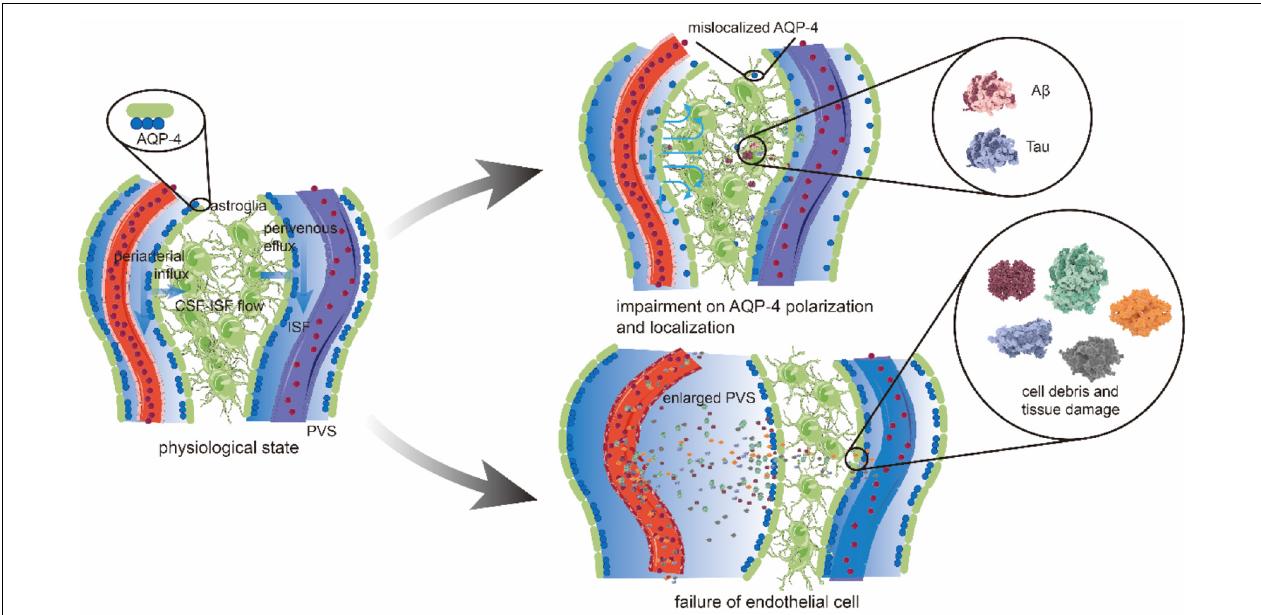
FIGURE 2 | The glymphatic pathway and pathological changes. CSF in periarterial spaces flows across the glial basement membrane and astroglial endfeet to enter the brain parenchyma. The aquaporin 4 (AQP4) is highly expressed on the endfeet of astrocytes, forming the outer wall of the perivascular space (PVS) and facilitating the CSF influx into the interstitium. After mixing with interstitial fluid (ISF) and waste metabolites, CSF is transported toward to perivenous space in a polarized net fluid movement. Ultimately, CSF exits along the lymphatic vessels and arachnoid granulations for the removement of solutes from the brain parenchyma accumulated during neural activity. Under pathological conditions, the brain may have an impairment on AQP4 polarization and localization. In patients with Alzheimer’s disease (AD), AQP4 depolarization leads to the reduction in CSF influx from periarterial space. At the same time, the direction of CSF-ISF flow is disrupted or even reversed, which reduces the ability and efficiency to transport amyloid β (A β ) protein. The concentration of A β increases gradually, and deposition occurs in the brain parenchyma and periarterial space. Vascular pathology causes endothelial cell (EC) failure, producing the cell debris and protein deposition that gives rise to the obstruction and inflammation of PVS. Increased PVS fluid and the abovementioned factors causes enlarged PVS, which then leads to a further accumulation of toxic metabolic by-products, such as A β and